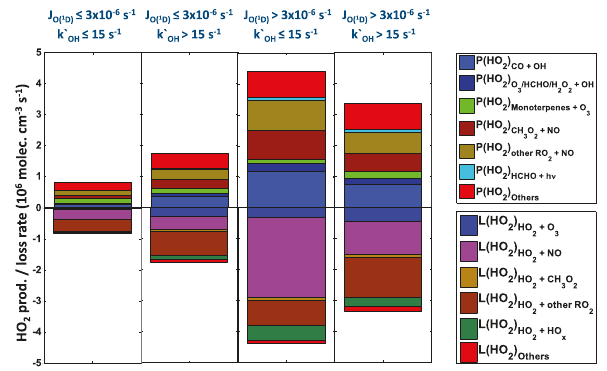
Figure 17. Simulated production and loss rates of HO 2 during HUMPPA-COPEC-2010 under conditions of different radiation and total observed OH